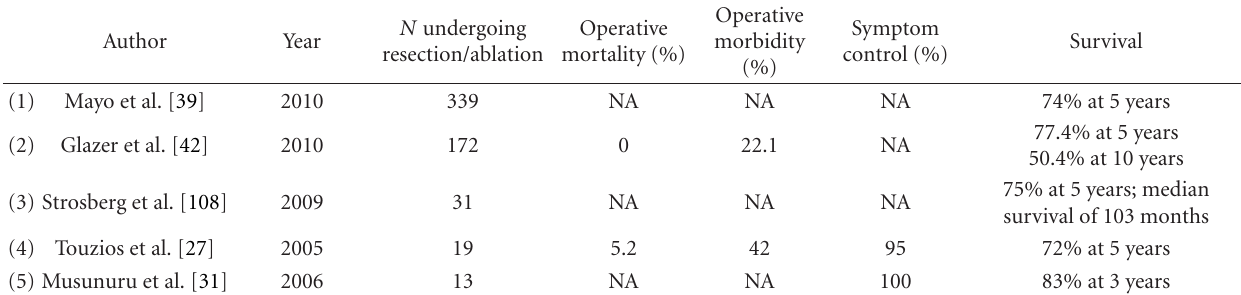
Table 2: Case series of hepatic resections with ablation performed for neuroendocrine liver